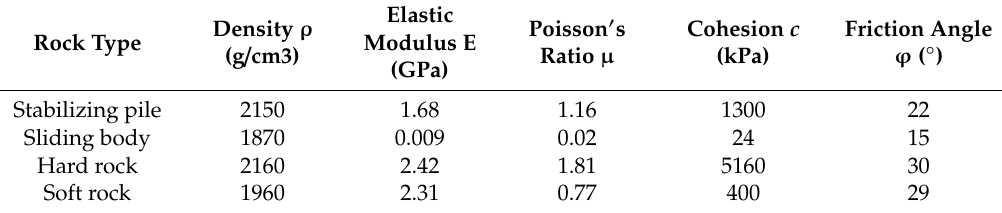
Figure 6. The raw materials of the mode. Table 3. Mechanical parameters of the similar materials.